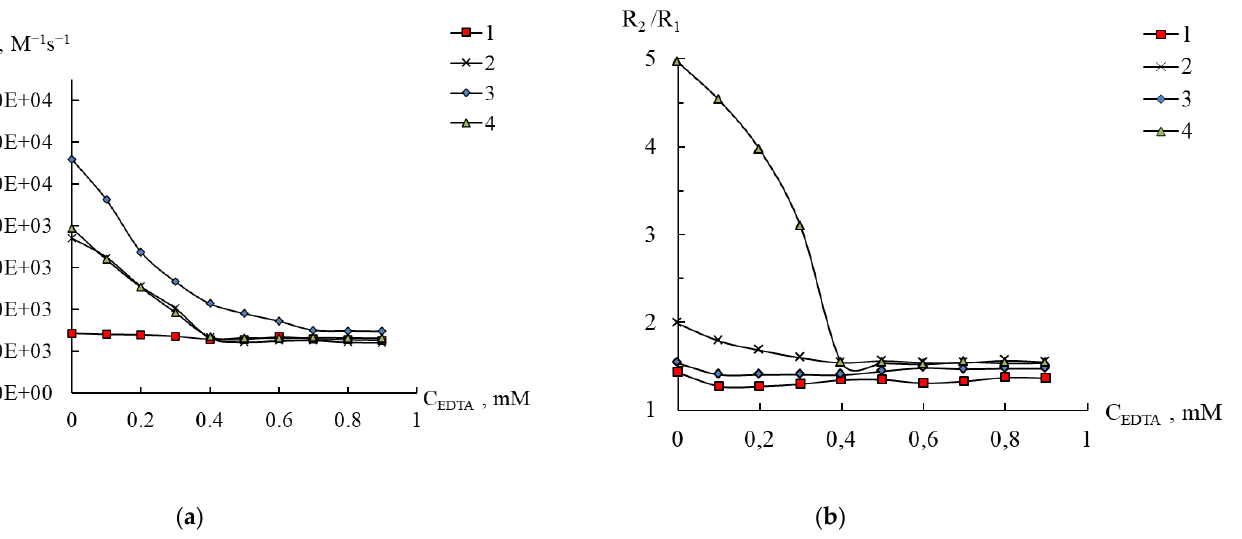
Figure 10. Changes in the relaxation efficiency R 1 ( a ) and the ratio R 2 /R 1 ( b ) on the content of EDTA in solutions of compounds 1–3 (1–3) and in an aqueous solution of aqua ions Mn(II) (4), С Mn(II) 0.2 (3), 0.4 mM (1, 2, 4), pH